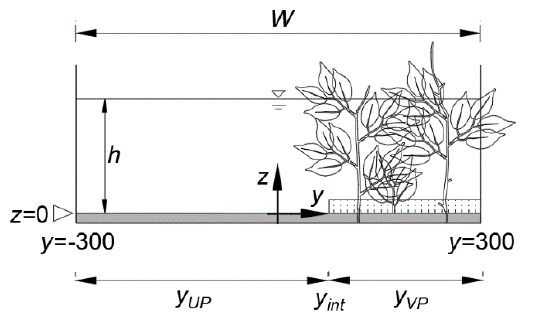
Figure 3. A cross-sectional view of the partly vegetated channel with the foliated plants and understory grasses (dotted area). The width of the channel W , the width of the unvegetated part y UP and the width of the vegetated part y VP , and the location of the main channel–vegetation interface y int (at y = 70 mm). All units are in millimeters.